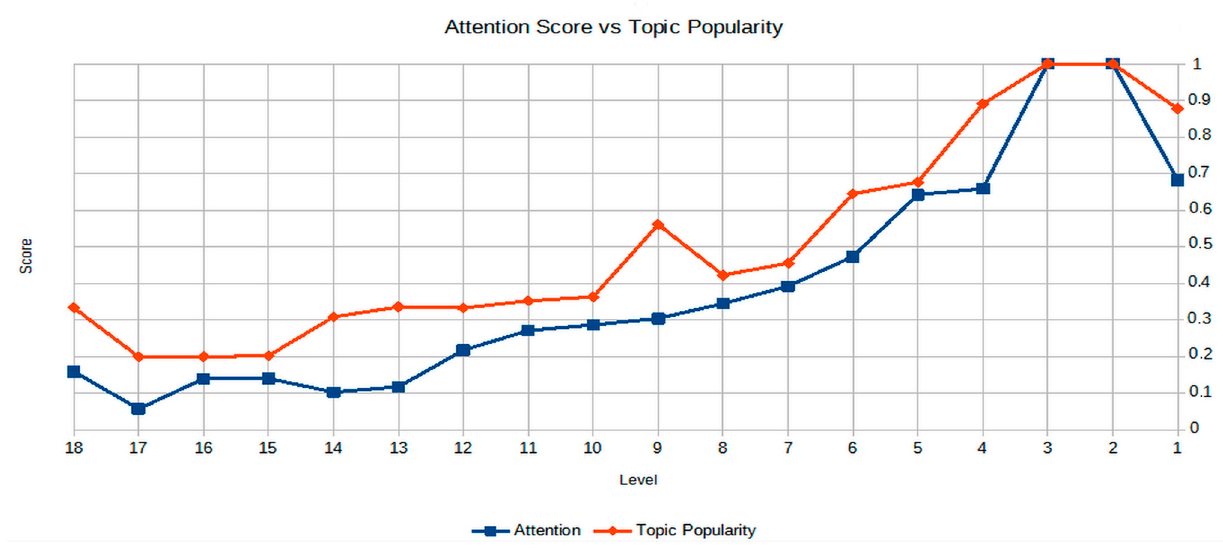
Figure 8. Attention score vs. topic popularity.